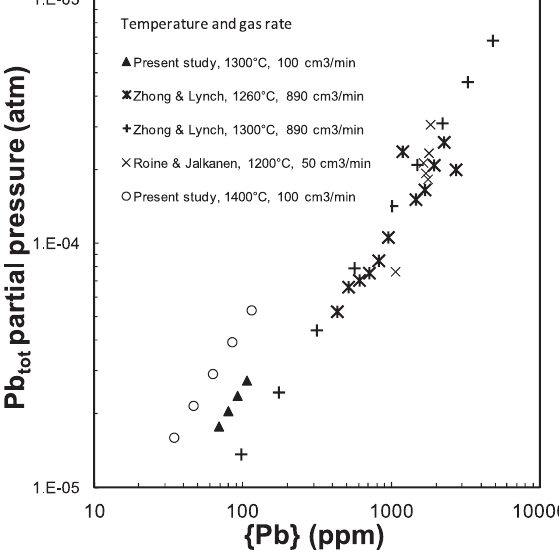
Fig. 6: Calculated partial pressure of total Pb as a function of Pb content in the matte from this study at 1300 °C and that from the literature [6, 8].